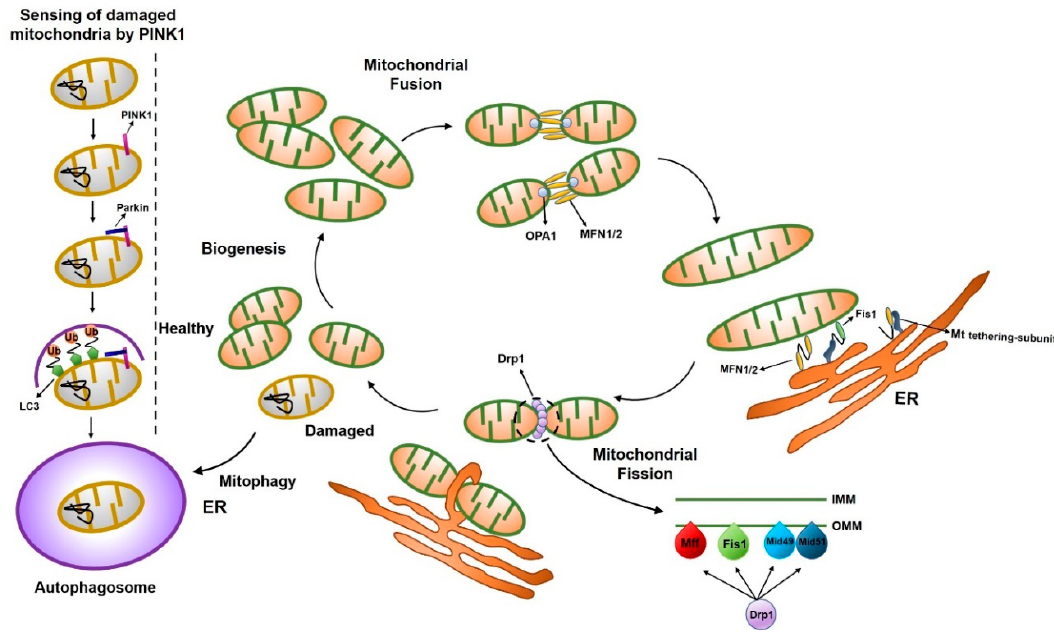
Figure 1. Schematic illustration of the mitochondrial dynamics. Mitochondria dynamically change their morphology through the cycle of fusion and fission. Main fusion factors are Opa1, Mfn1, and Mfn2, which bind to the inner membrane (IMM) and outer membrane (OMM) of mitochondria. Drp1 is a major fission factor that binds to OMM and forms a ring-like structure around mitochondria, leading to the separation of mitochondria into two, where endoplasmic reticulum (ER) contact occurs. Mff, Fis1, Mid49, and Mid51 function as adaptors to recruit Drp1 to the OMM. Protein phosphorylation is a posttranslational modification that regulates protein function and